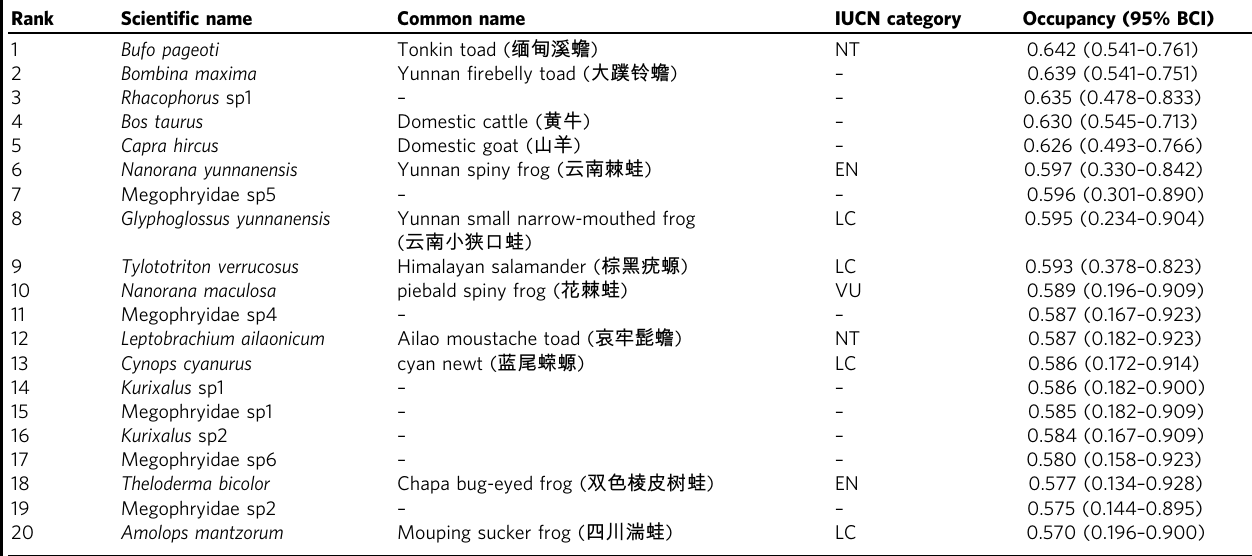
Table 1 Top species by estimated occupancy in the LSU dataset.